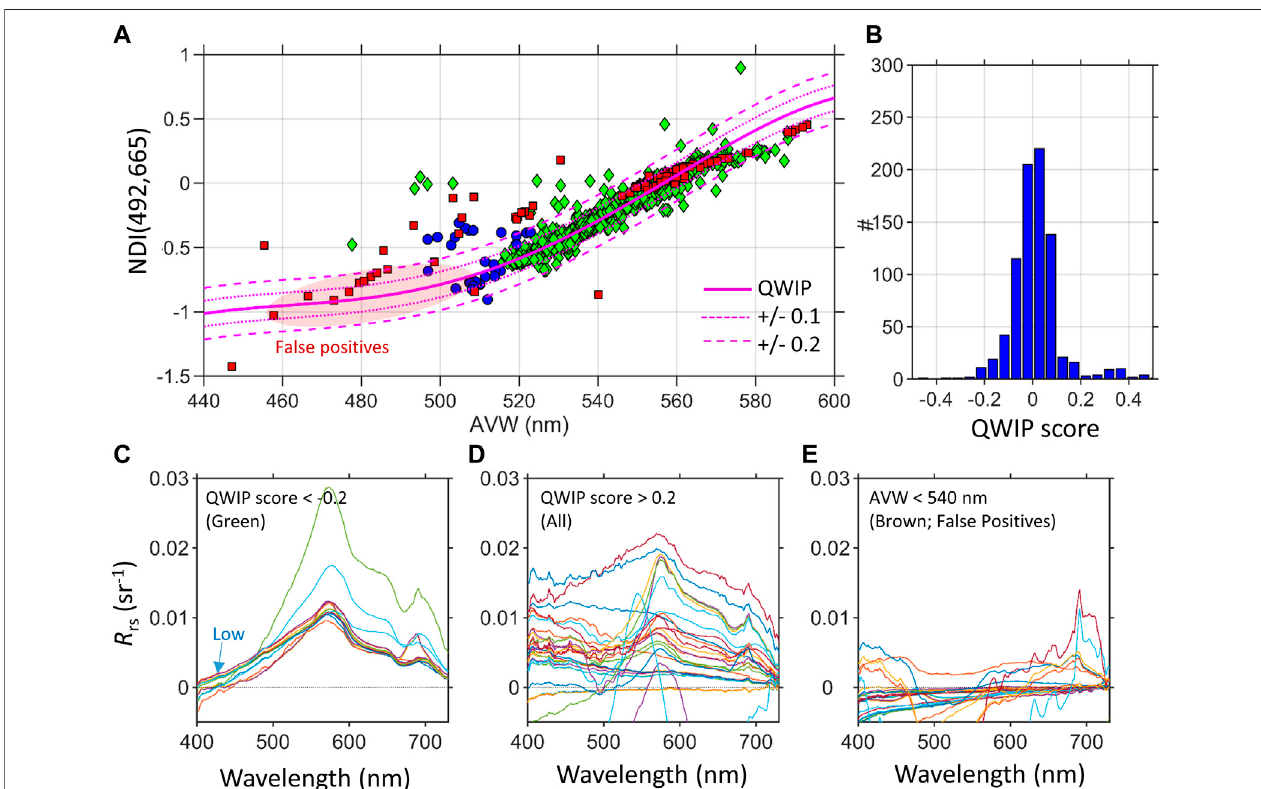
FIGURE6|(A) TheQWIPapproachwasusedforqualitycontrolofarawWISPdataset.Watertypesinclude:Blue-green(bluecircles),Green(greendiamonds)and Brown (red squares) following from Figure 2 . The red circle highlights false positive data of brown water type that coincidentally fall within the polynomial limits. (B) The majorityofthedatahadQWIPscoresof±0.2. (C) Remotesensingre fl ectance( R rs )ofgreenoutlierswithslightlynegativescoreshadgoodspectralshapesbuttoolowin the blue. (D) High QWIP scores were related to the outliers ofbad data with unusual spectral shapes. (E) Brown outliers with failing spectral shapes were identi fi ed as having lower AVW than expected for the water type (AVW < 540 nm).